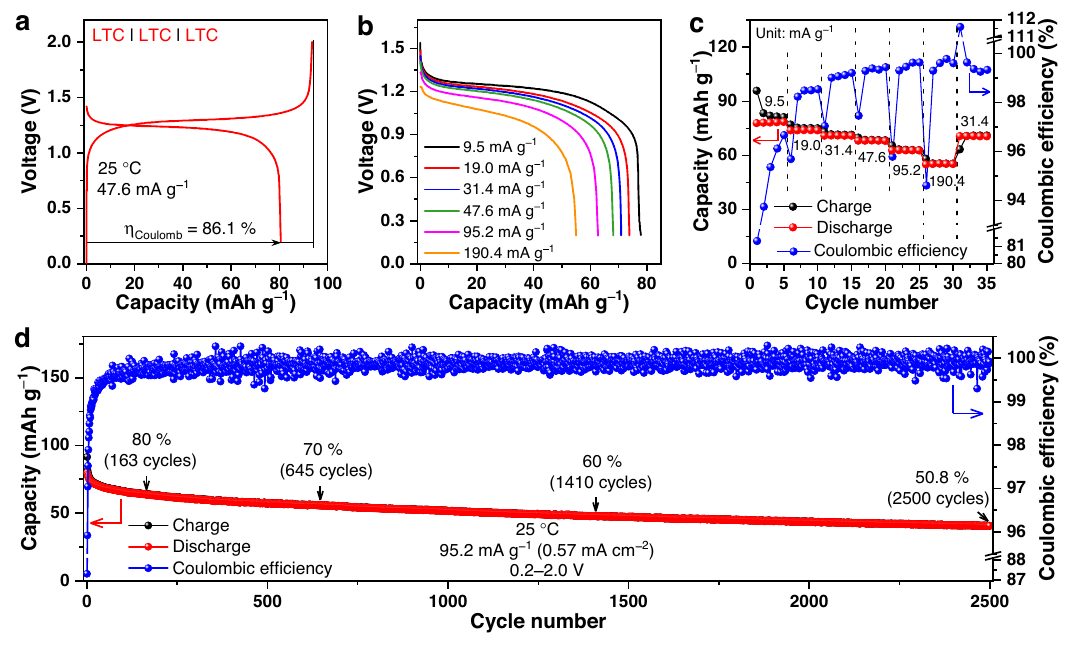
Fig.6|Electrochemicalperformanceofthesingle-LTCcells.a Theinitialcharge/ discharge curves under 47.6mAg − 1 at 25°C. b , c Rate capability at 9.5, 19.0, 31.4,